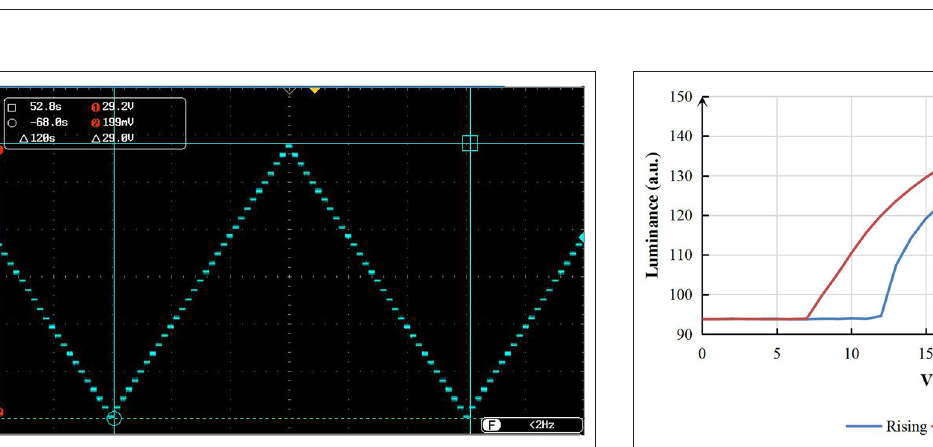
FIGURE 4 | The experimental platform for driving EWDs. (A) Oscilloscope. (B) Arbitrary waveform generator. (C) Power amplifier. (D) Colorimeter. (E) EWD panel. (F) Host software of colorimeter. (G) Host software of waveform generator.